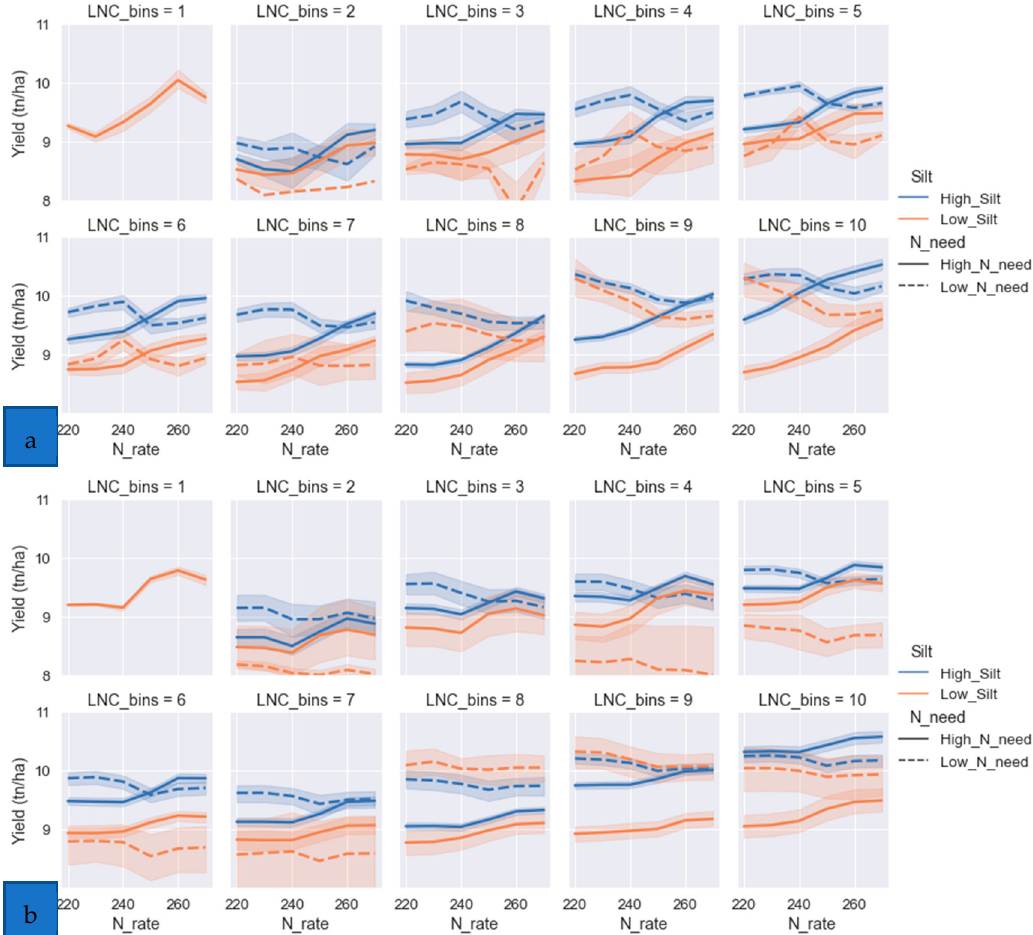
Figure 6. Effect of different N levels on yield prediction according to the ML model based on ( a ) data reconstructed using VAE and ( b ) normal data for rice requiring high and low N doses and grown in soils with high and low silt levels.